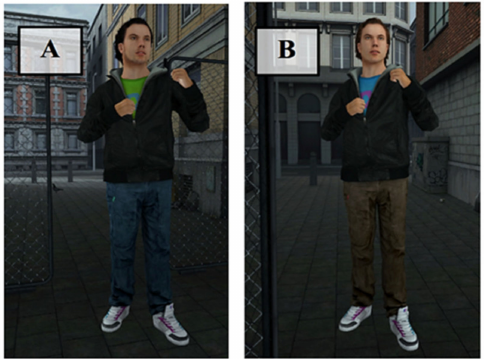
Figure 2. ( A ) Avatar in proactive condition; ( B ) avatar in reactive condition.